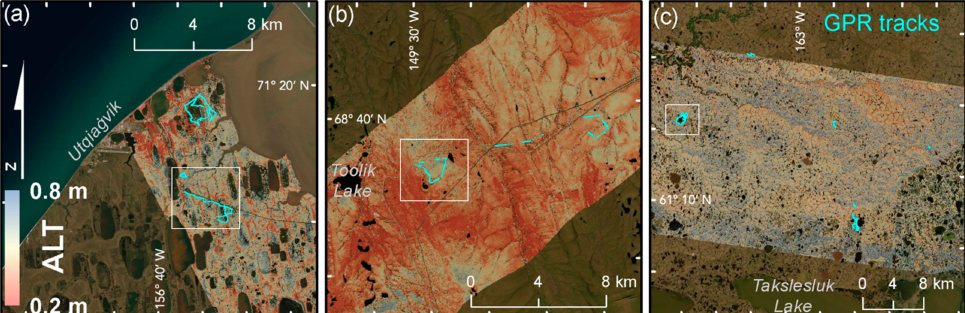
Figure 2. Ground penetrating radar (GPR) tracks displayed over the PDO product for the ( a ) BRW, ( b ) TOO, and ( c ) YKD swaths. The locations of these swaths are indicated in Figure 1. White boxes indicate locations shown in Figure 9. Latitude and longitude tick marks are in 5’ intervals. Dark patches within the terrestrial landscape are water